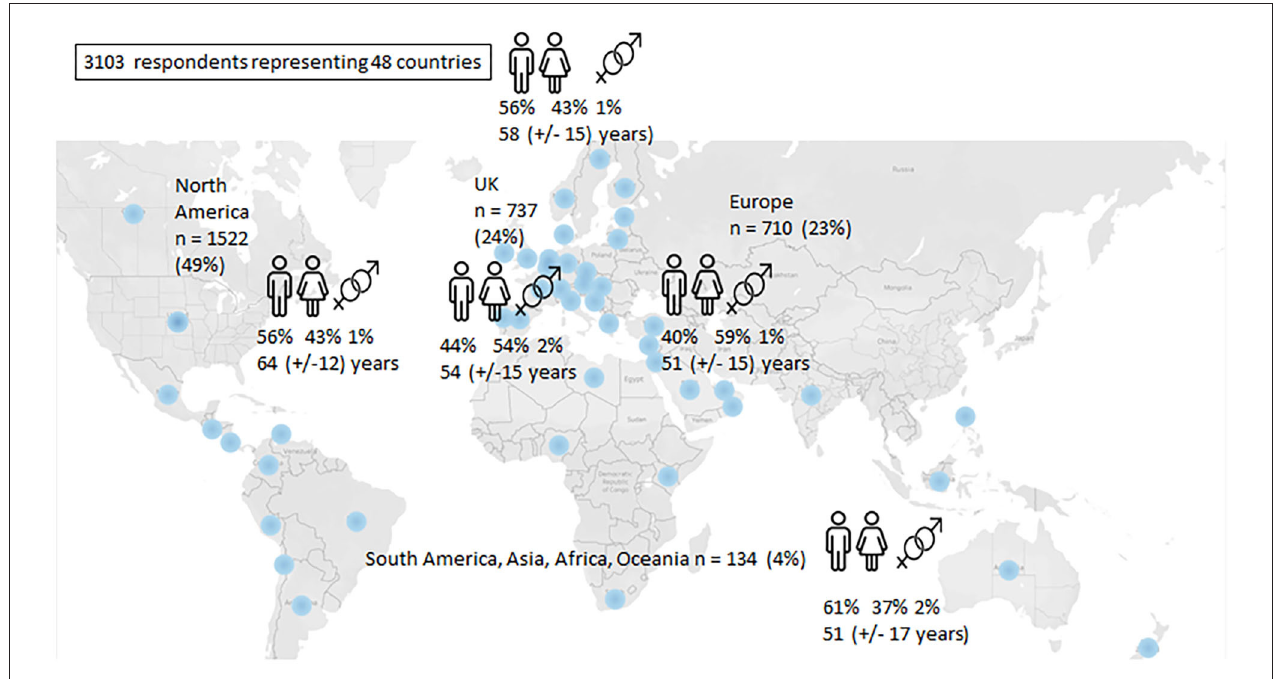
FIGURE 1 | Distribution of